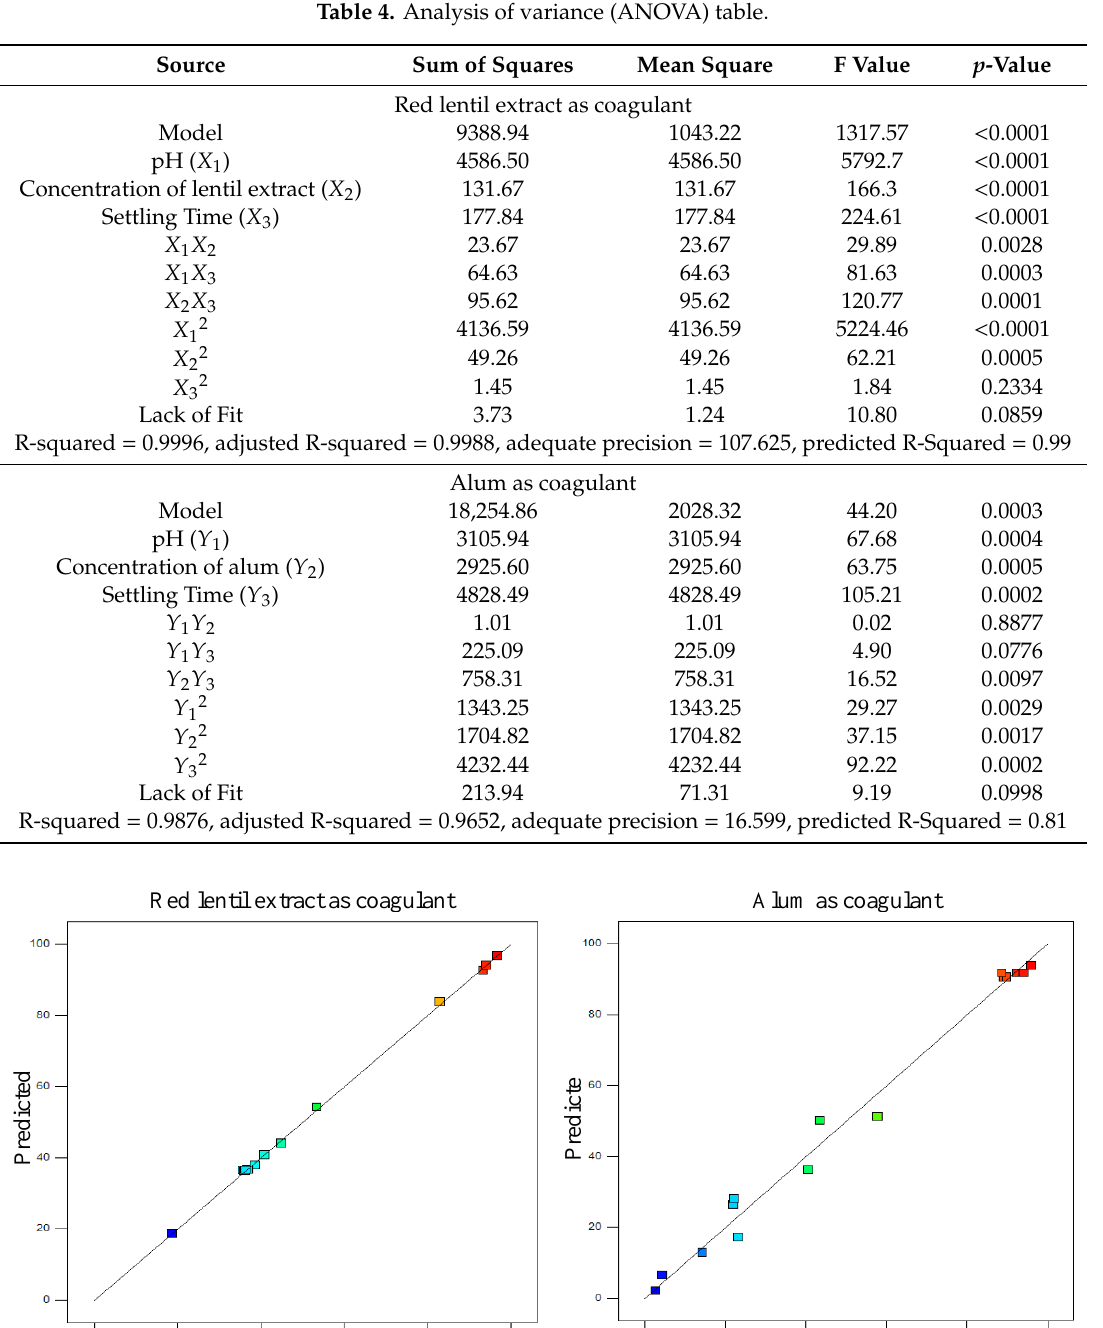
Table 4. Analysis of variance (ANOVA) table.